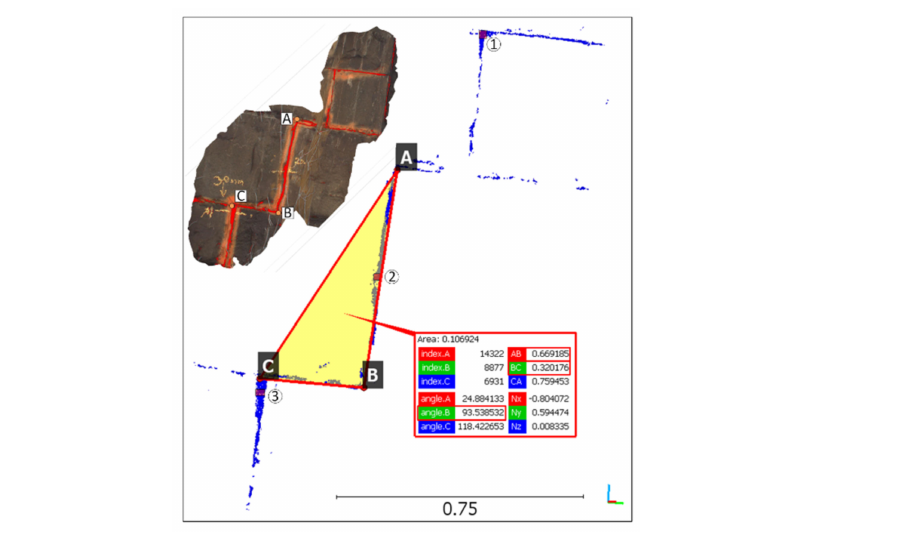
Figure 22. Damage measurement of detected damage by intelligent hierarchical DSfM.